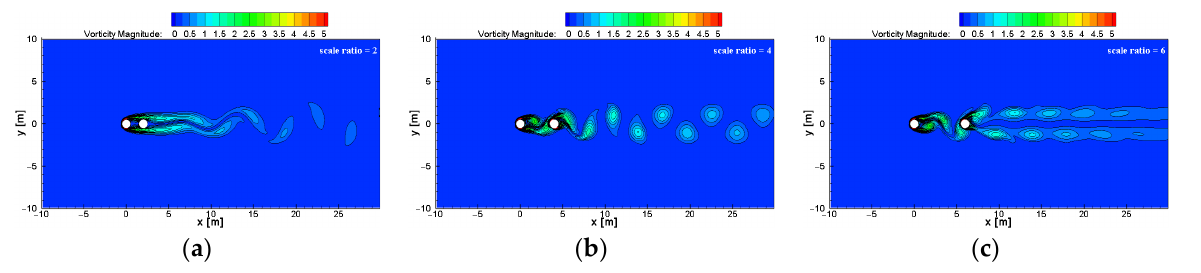
Figure 16. Contour maps of vorticity magnitude around two circular cylinders with spacing ratios of ( a ) 2, ( b ) 4, and ( c ) 6 at t = 400 s ( Re = 100).